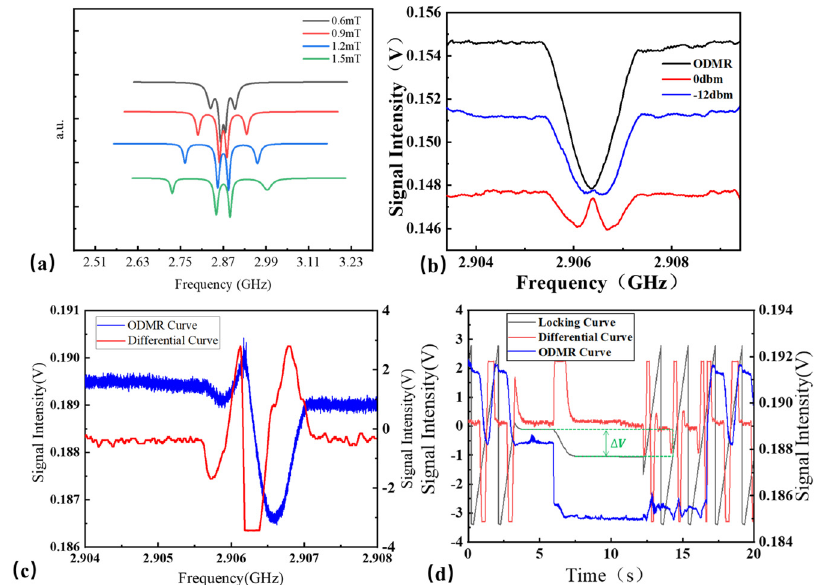
Figure 3. Diagram of experimental test results. ( a ) Schematic diagram of frequency detection method for fi xed-frequency microwave using magnetic fi eld intensity scan. ( b ) ODMR diagram of for fixed-frequency microwave using magnetic field intensity scan. ( b ) ODMR diagram of microwave microwave frequency resonance with di ff erent intensities. ( c ) ODMR spectral curve in CPO and its frequency resonance with different intensities. ( c ) ODMR spectral curve in CPO and its first-order fi rst-order di ff erential curve. ( d ) Microwave frequency closed-loop locking and microwave fre- differential curve. ( d ) Microwave frequency closed-loop locking and microwave frequency resonance quency resonance ODMR conversion diagram. ODMR conversion